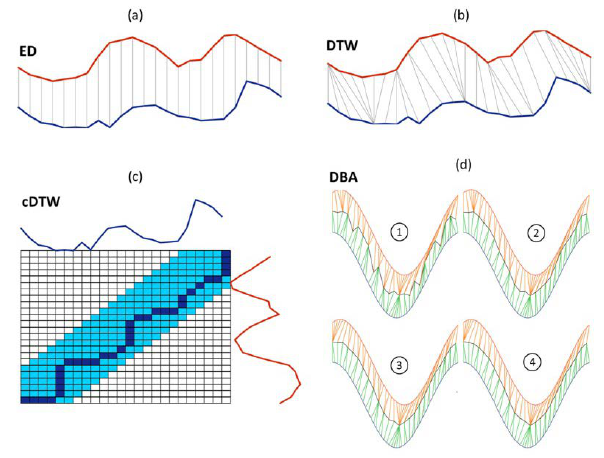
Figure 4. The operating principles of Euclidean Distance (ED), Dynamic Time Warping (DTW), The Constrained Dynamic Time Warping ( c DTW), and the Dynamic Time Warping Barycenter Averaging (DBA). ( a ) Similarity computation under ED; ( b ) similarity computation under DTW; ( c ) Sakoe-Chiba band with a warping window of 5 cells (light blue cells in band) and the warping path computed under c DTW (dark blue cells in band) [23]; ( d ) centroid computation through the Dynamic Time Warping Barycenter Averaging (DBA) [55].